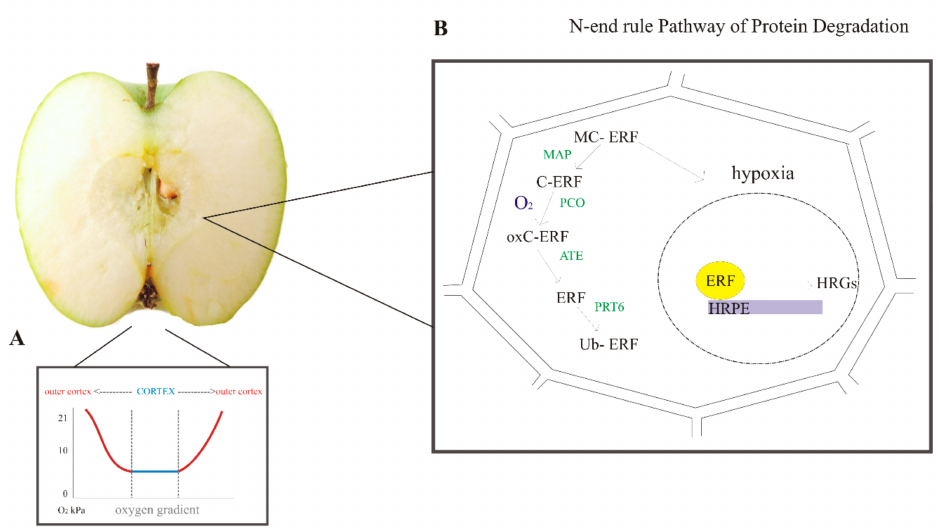
Figure 2. Fruit tissue hypoxia and oxygen signaling pathway. ( A ) Bulky fruit, such as apple, can be hypoxic under a normal oxygen environment, where the lowest oxygen concentrations are found in the cortex. The graph illustrates the possible gradient formed inside the fruit in normal oxygen conditions (adapted from Paul and Pandey [34]). ( B ) The oxygen concentration in the cortex can reach very low values, and the cell can experience hypoxia. Hypoxia triggers the accumulation of ERFs in the nucleus, which can bind the hypoxia-responsive promoter element (HRPE) sequence, which in turn activates transcription of hypoxia-responsive genes (HRGs). On the other hand, under normal oxygen conditions, ERFs are subjected to enzymatic degradation via the N-end rule pathway. Enzymes are shown in green. MAP, methionine aminopeptidase; PCO, plant cysteine oxidase; ATE, arginyl-tRNA transferase; PRT6-E3, ubiquitin ligase proteolysis; MC-ERF, amino acid sequence of the protein; oxC-ERF, oxidation of the cysteine residue; Ub-ERF, ubiquitination of ERF. Although the available literature indicates ERF degradation via the N-end rule pathway, genes coding the enzymes involved in the N-end rule pathway of protein degradation have yet to be identified. Therefore, this is an illustration of ERF oxygen signaling based on knowledge obtained in Arabidopsis and apple fruit (adapted from Licausi et al. [64]).